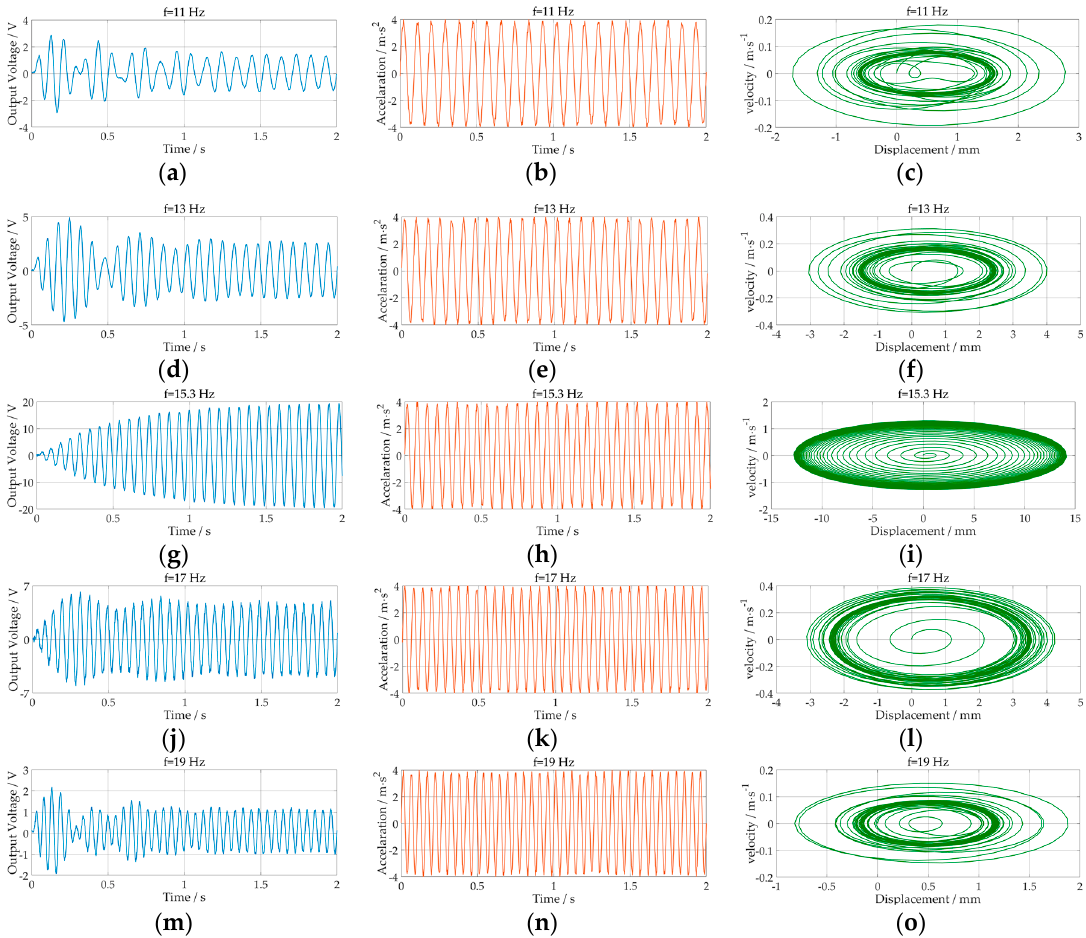
Figure 11. Time series for the output voltage, acceleration in experiment and corresponding phase portraits curve in simulation: ( a – c ) 11 Hz; ( d – f ) 13 Hz; ( g – i ) 15.3 Hz; ( j – l ) 17 Hz; ( m – o ) 19 Hz.